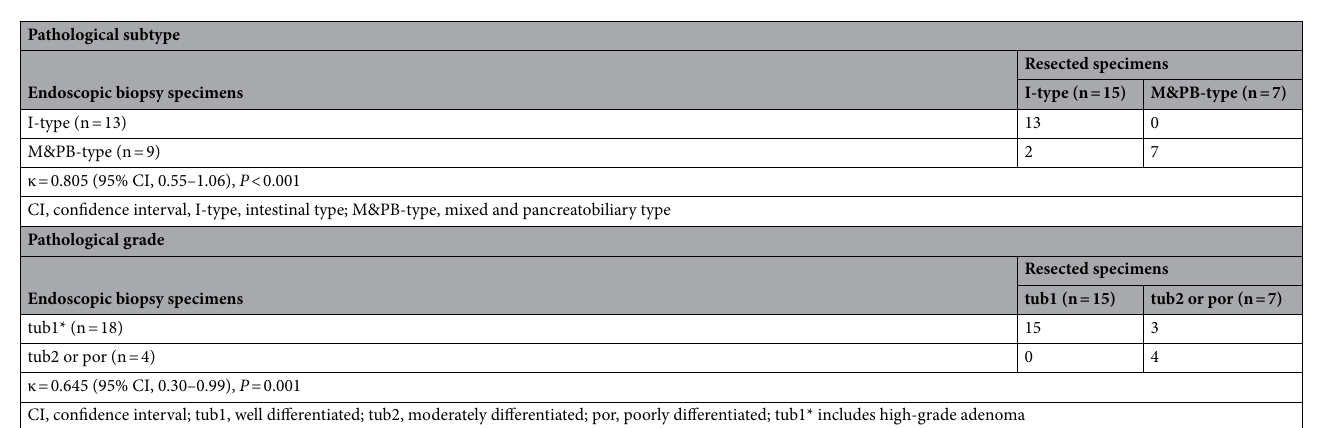
Table 2. Diagnostic concordance of pathological subtype and grade between endoscopic biopsy specimens and resected specimens (n =